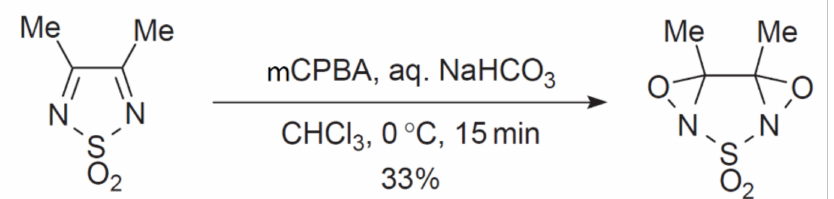
Figure 10. Oxidation of C=N bonds in 3,4-dimethyl 1,2,5-thiadiazole 1,1-dioxide with mCPBA leading to bis-oxaziridine